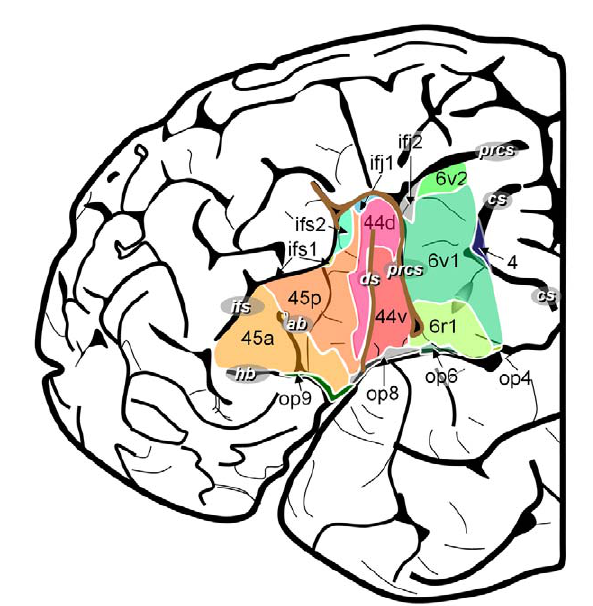
Figure 9. Extent of delineated areas projected to the lateral surface of an individual postmortem brain. Same hemisphere as shown in Figure 7. doi:10.1371/journal.pbio.1000489.g009 thickness (Figure S1). Tissue blocks containing the posterior part of